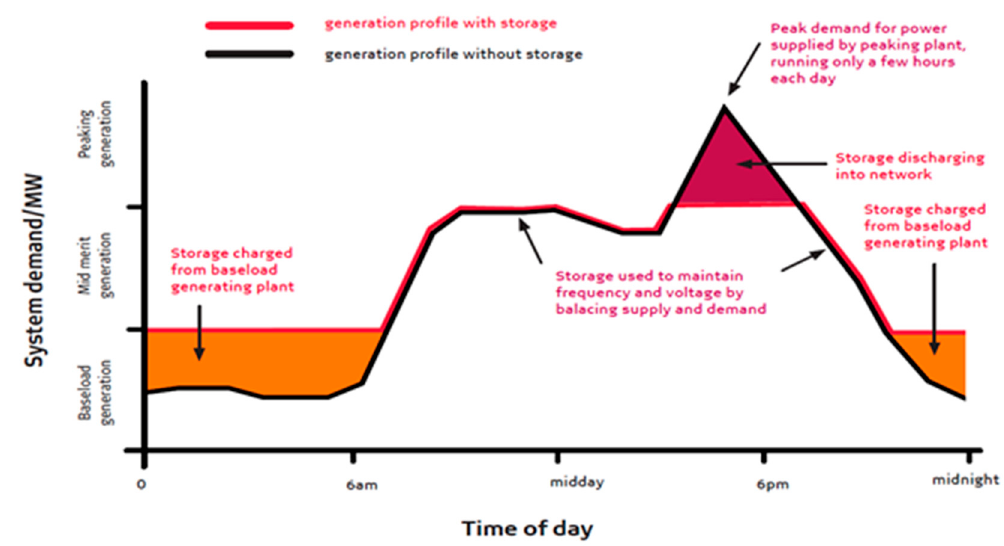
Figure 12. Peak shaving application for BESS.